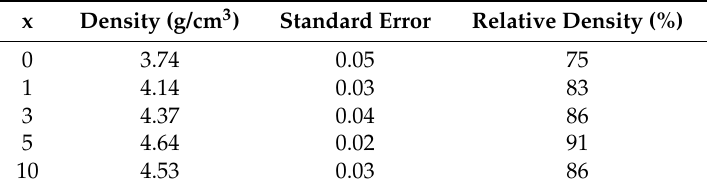
Table 1. Mean densities of Ca 0.99 Yb 0.1 MnO 3 + x wt.% Ag samples, together with their standard errors. Relative densities are also given, taking as the theoretical density 4.99 g/cm 3 for Ca 0.99 Yb 0.1 MnO 3 [20], and 10.5 g/cm 3 for Ag [28]. x Density (g/cm 3 ) Standard Error Relative Density